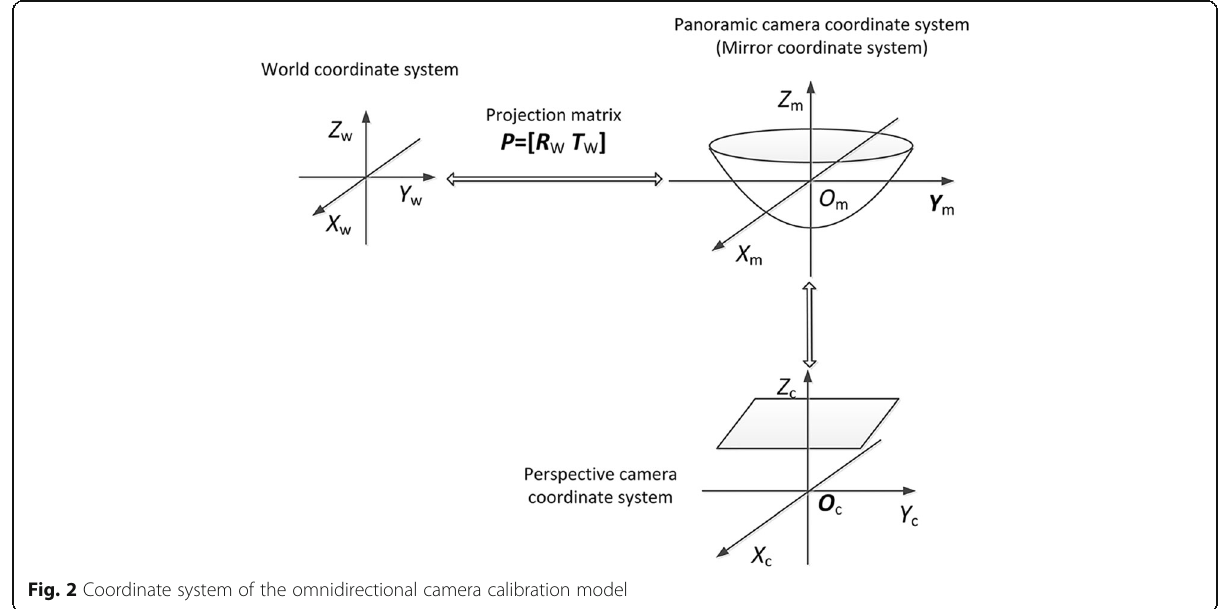
Fig. 2 Coordinate system of the omnidirectional camera calibration